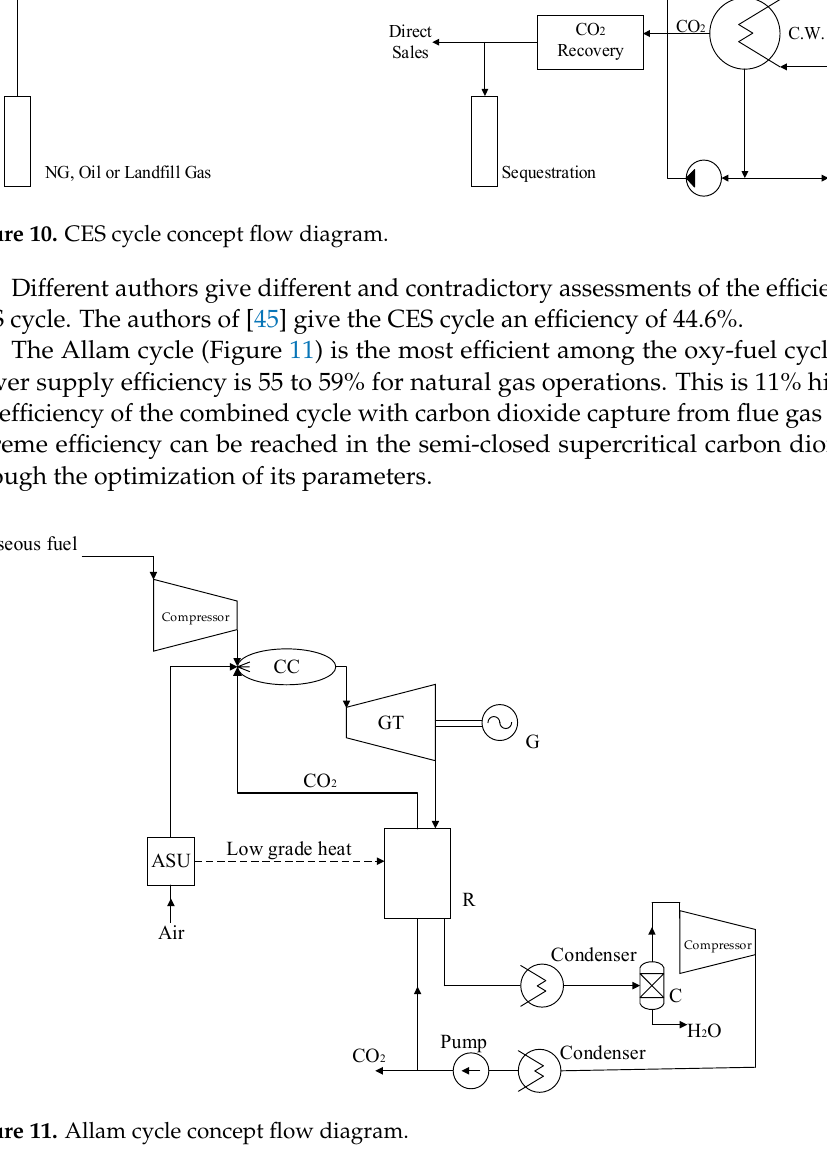
border. Under this condition, the carbon dioxide is practically incompressible, so the power spent for its compression is minimal. The intermediate coolers of the multi-stage compressor also reduce the compression work. The practically incompressible fluid pres- is produced by a pump. The high minimal pressure of the cycle of about 30 bar enables before its storage. The low-potential heat produced in the oxygen production in the air separation unit (ASU) is supplied to the regenerator to heat the CO 2 flow from 100 to 400 ° С , which also improves the cycle efficiency.